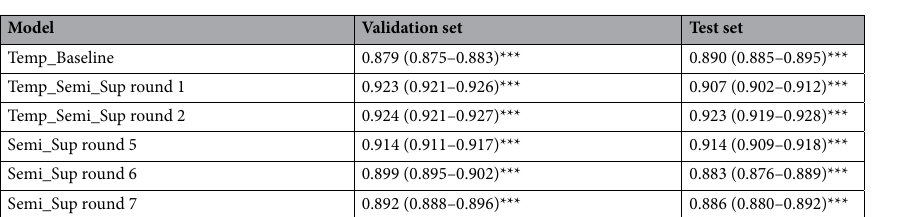
Table 5. AUC and 95% C.I. on the validation and test sets. Differences between each SSL round and the Temp_baseline were tested for statistical significance. Asterisks (*) indicate p value < 0.05 (*), p value < 0.01 (**), and p value < 0.001 (***),